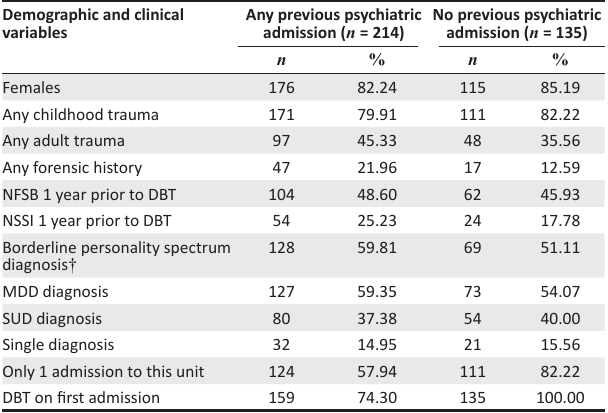
TABLE 3: Selected characteristics of patients with any previous psychiatric admission compared with patients with no previous psychiatric admissions. Demographic and clinical variables